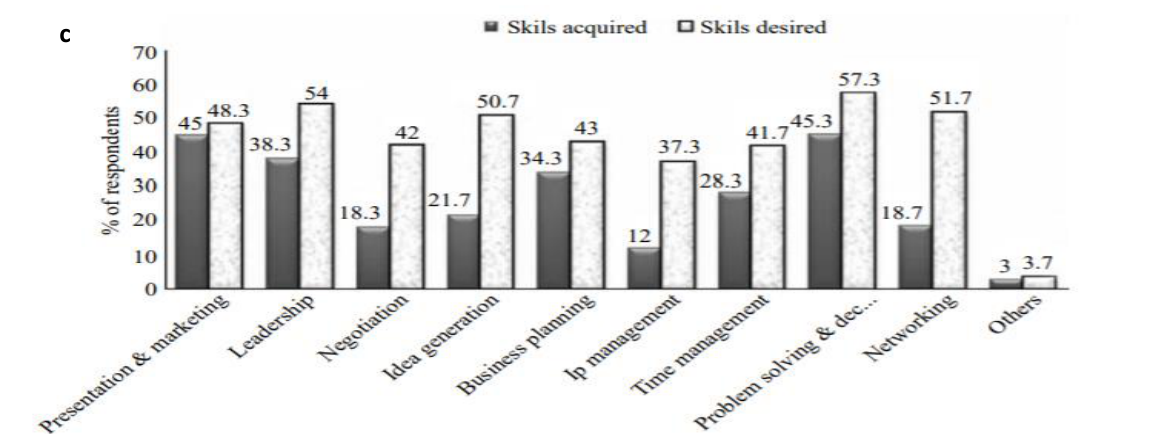
Figure 5: Identified Entrepreneurial Skills and Impact on Entrepreneurship Development; (a) Skills Identified (b) Entrepreneurship Impact (c) Desired and Acquired Skills (cheng et al., 2009); Source : (a) and (b) Prepared by